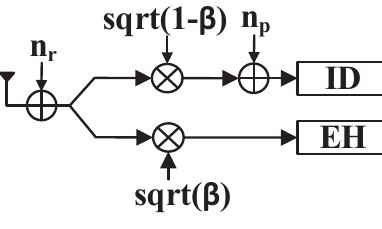
Figure 2. The PS